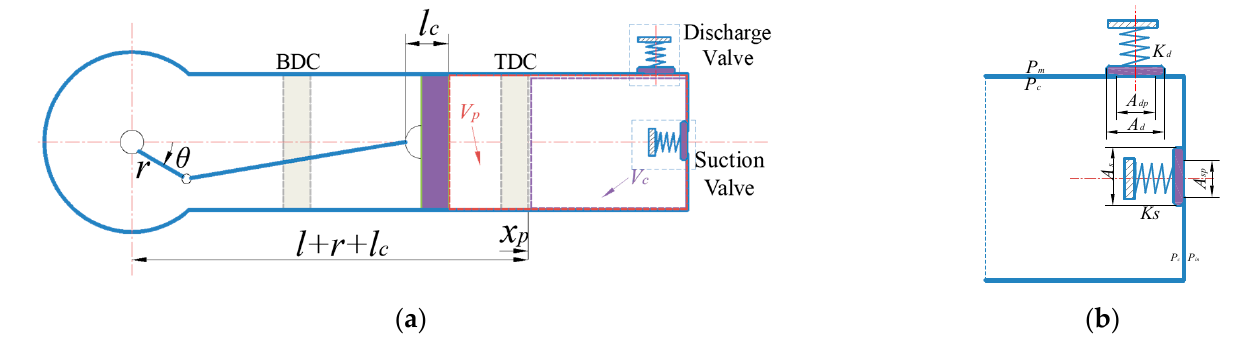
Figure 1. Schematic diagram of reciprocating pump hydraulic end and pump valve. ( a ) Simplified physical model of liquid hydrogen reciprocating pump; ( b ) Suction valve and discharge valve schematic.